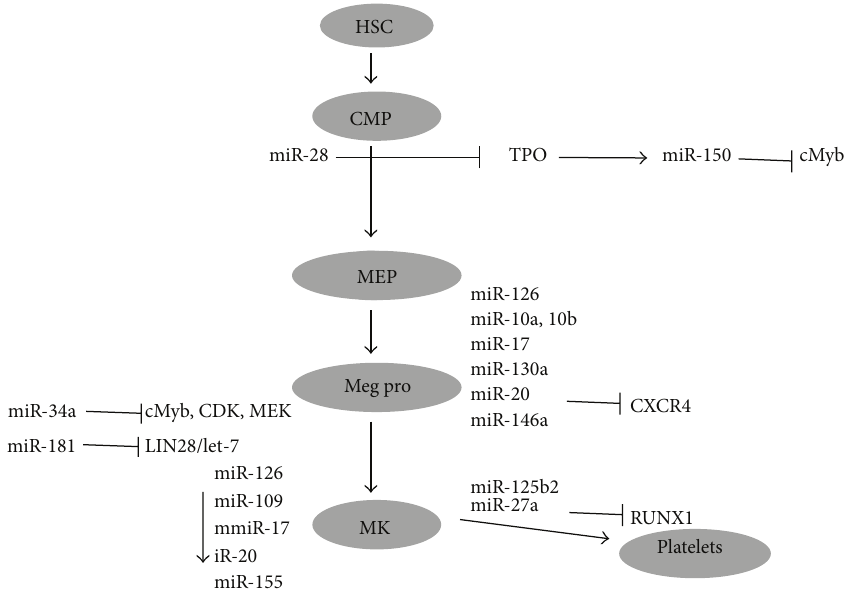
Figure6:miRNAinmegakaryopoiesis.miRNAsplayingcrucialroleinthedevelopmentofmegakaryocyte(MegP-megakaryocyteprogenitor, CMP-common myeloid progenitor, MEP-megakaryocyte erythroid